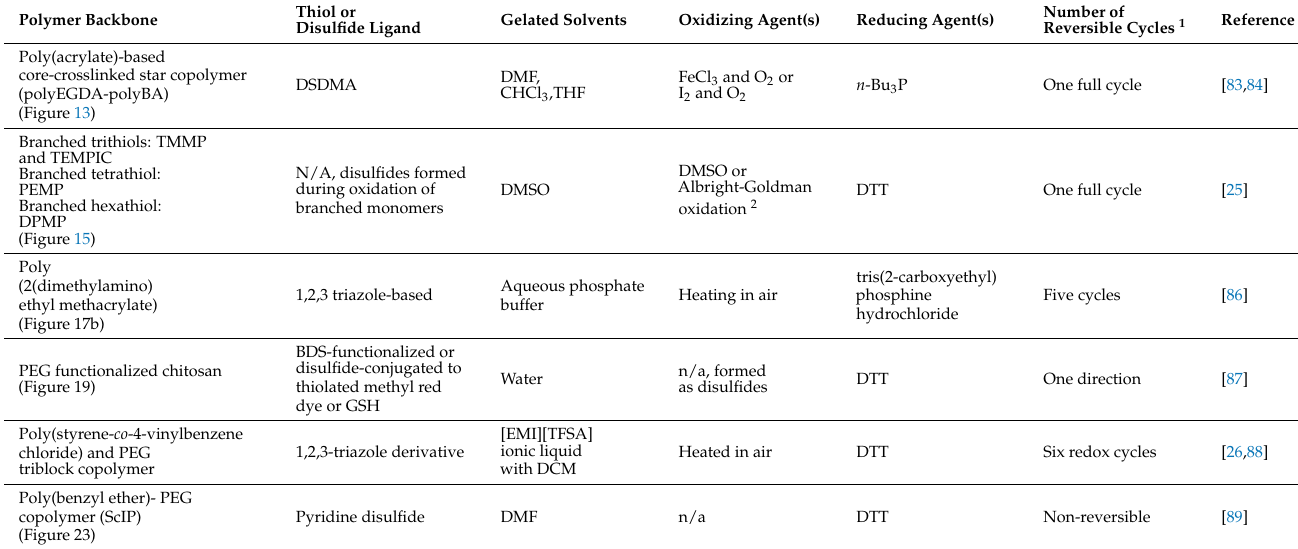
Table 1. Redox-Reversibility in Disulfide-Crosslinked